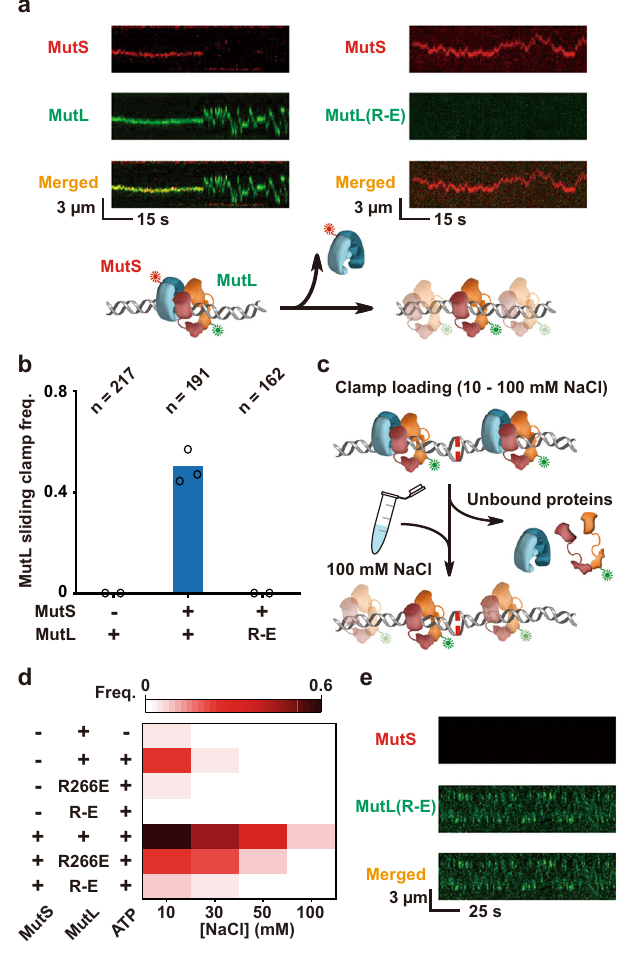
Fig.3|MutSandDNAcooperatewiththeMutLNTDpositivelychargedcleftto load a MutL sliding clamp onto the mismatched DNA. a Representative kymo- graphs (top) and illustration (bottom) showing the formation of a fast-diffusion Cy3-MutL sliding clamp from a Cy5-MutS/Cy3-MutL complex (left), while no com- plexes or Cy3-MutL(R-E) sliding clamps (right) were observed under physiological ionic conditions (~120mM). Cy5-MutS and Cy3-MutL color-coded as described in Fig. 2b. b The frequency and component requirements for fast-diffusing MutL sliding clamps on the mismatched DNA under physiological ionic condition (~120mM, n =totalnumberofDNAmoleculesexamined). c Anillustrationshowing the reaction and wash sequence to examine the frequency of fast-diffusing Cy3- MutLclampsloadedontoamismatchedDNAundervariousionicconditions.MutS and Cy3-MutL color-coded as described in Fig. 2b. d Heat map of the frequency of fast-diffusing MutL sliding clamps with various included MMR components (left) and ionic loading conditions (bottom; see: Supplementary Table 4). e Representa- tivekymographsshowingMutSwithDNAcanloadafast-diffusingMutL(R-E)sliding clamp under very low ionic strength conditions